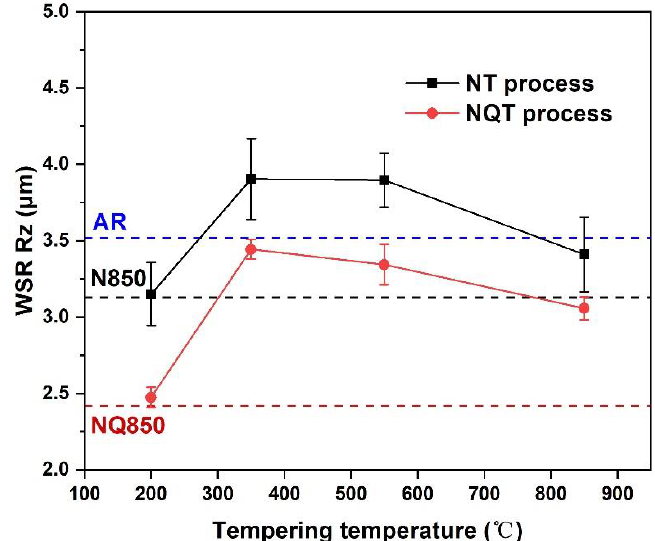
Figure 8. Variation of WSR under different material states.